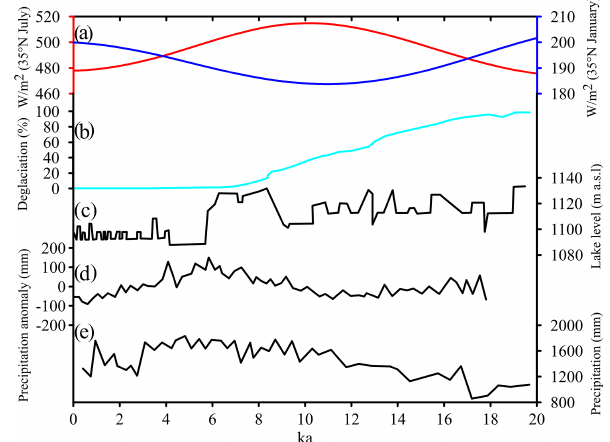
Figure 4. Changes of insolation, ice sheet and typical lake records since the LGM. (a) Summer and winter insolation variations at 35 ◦ N (Laskar et al., 2004); (b) percent area change of ice sheets in North America (Dyke, 2004); (c) lake-level variation from Owens Lake, western USA (Bacon et al., 2020); (d) pollen-based an- nual mean precipitation record for lakes Dalianhai and Qinghai on the northeastern Tibetan Plateau, western China (Li et al., 2017); (e) pollen-based annual precipitation change (modern analogues technique) at Lake Barombi Mbo, northern Africa (Lebamba et al.,